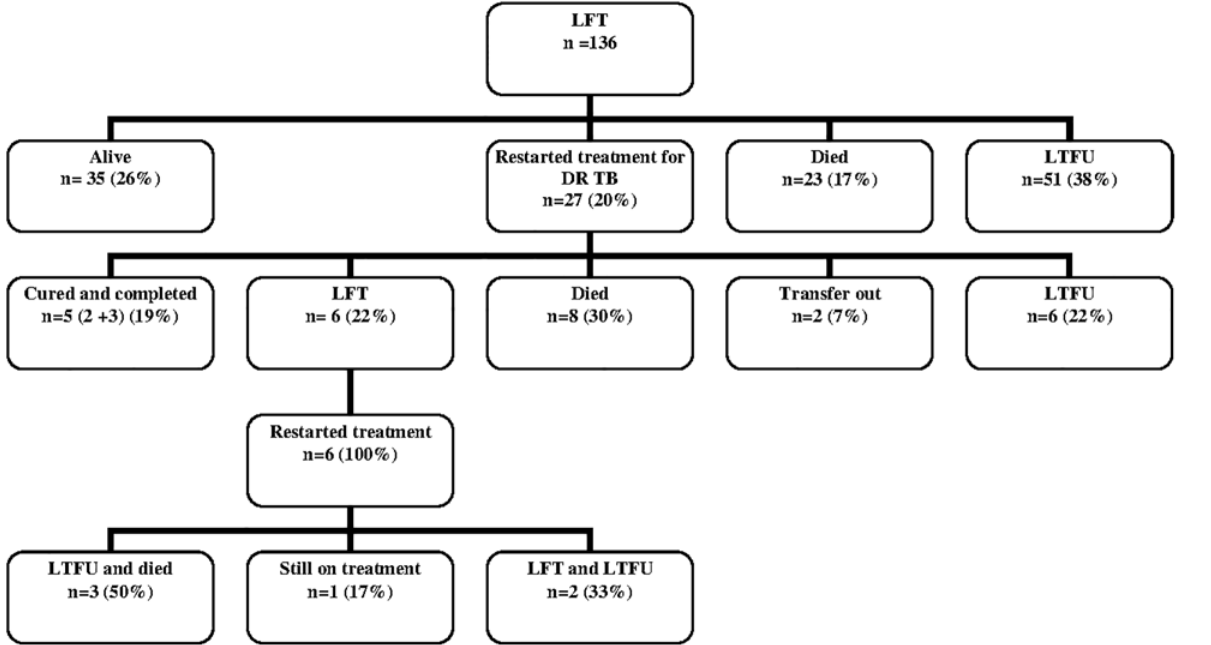
Fig 2. Post treatment outcomes of the patients lost from DR-TB treatment (January 2009-July